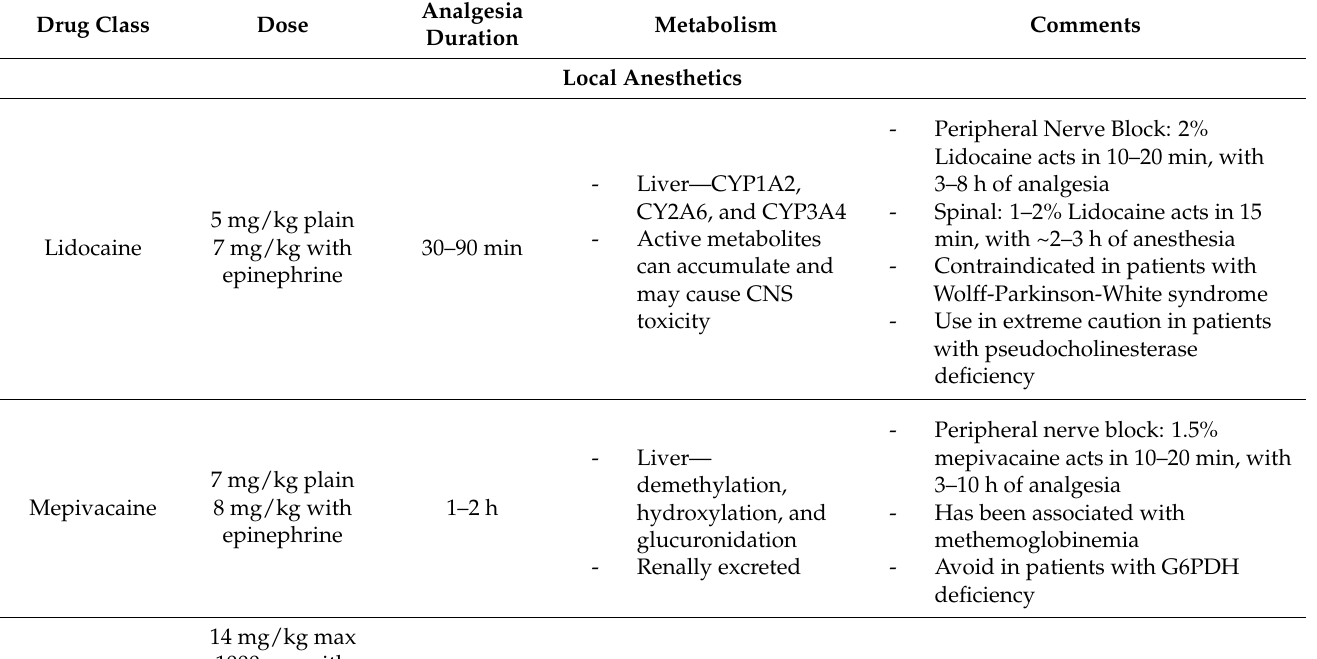
Table 6. Local anesthetics